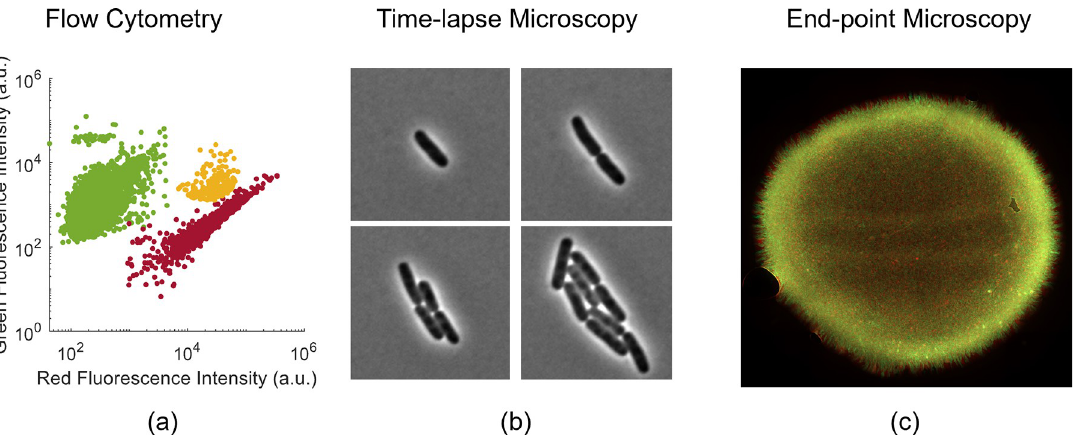
Fig 2. Single-cell measurement techniques for microbial communities. (a) Flow cytometers can measure cell fluorescence and morphology in large sample sizes. (b) Time-lapse microscopy allows for direct visualization of physical cell–cell interactions and quantitative measurement of single-cell characteristics over time. (c) End-point microscopy can illustrate large-scale spatial patterns and features of cell arrangements in 2 or 3 dimensions.